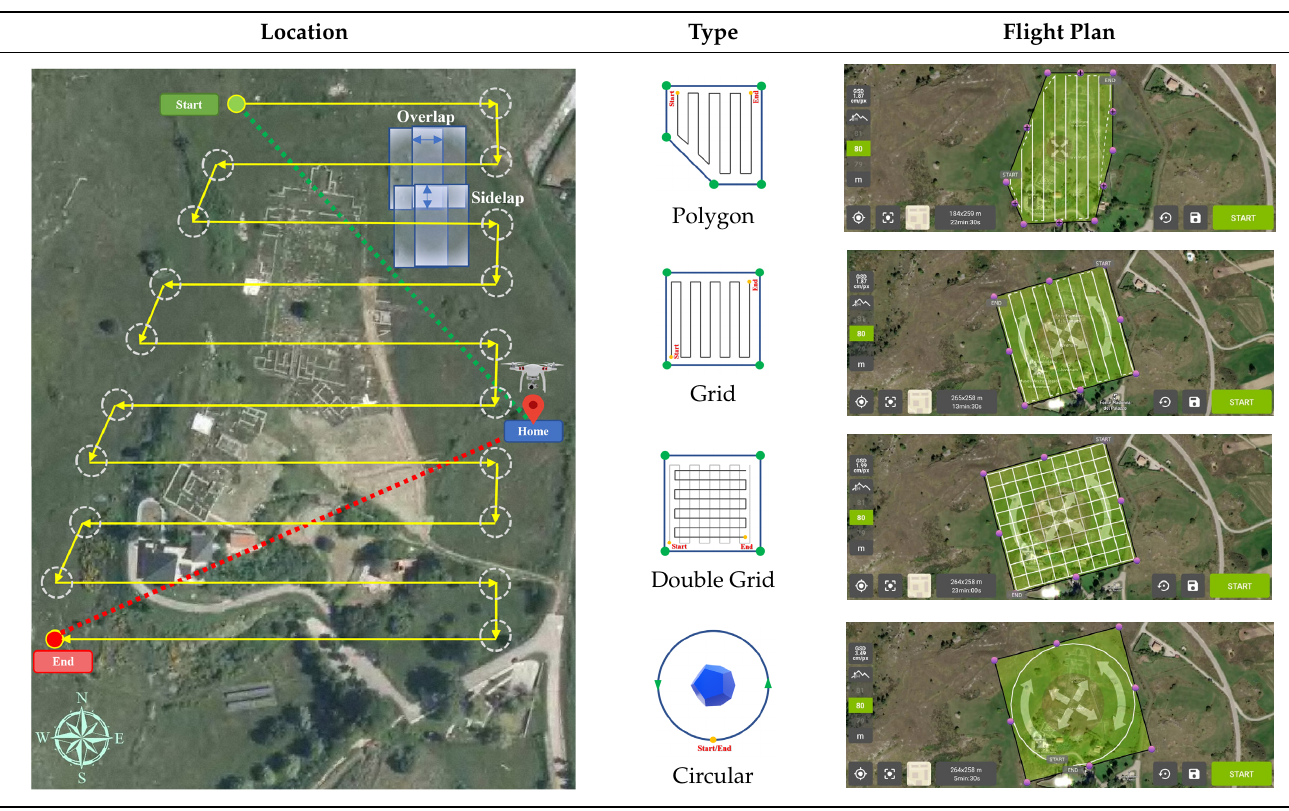
Table 6. Software for flight and mission planning.